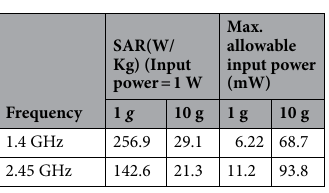
Table 4. Maximum SAR and maximum allowable input